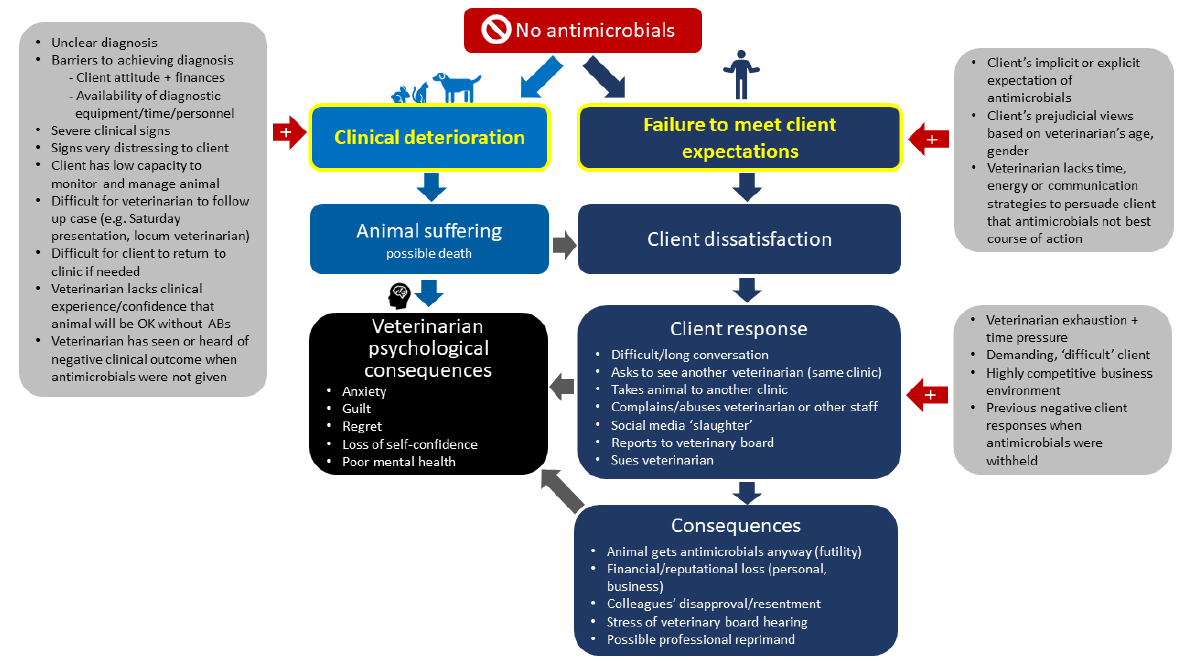
Figure 5. Schema of the dominant behavioural beliefs that interviewees associated with withholding or delaying antimicrobial treatment. Secondary factors that heighten fears are shown in grey.